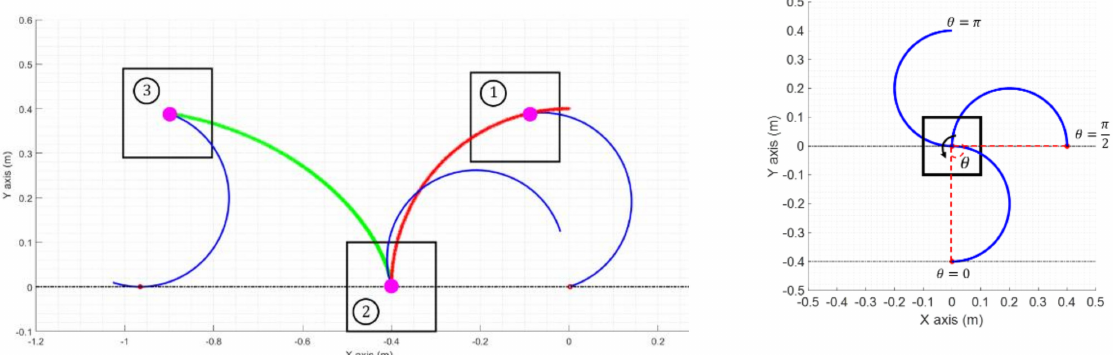
Figure 3. Trajectory is described by the system’s hip throughout a complete revolution ( left ) representation of angle θ and the orientations at which the motion of the system changes ( right